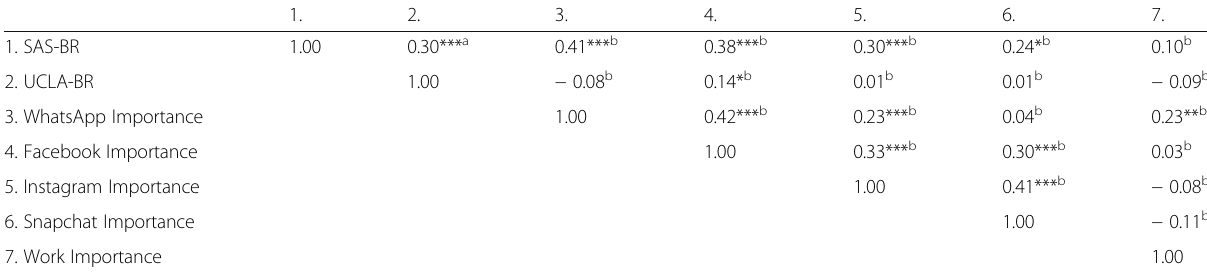
Table 2 Correlation table of the correlations between SAS-BR scores, UCLA-BR scores, social apps importance scores, and using smartphone for work